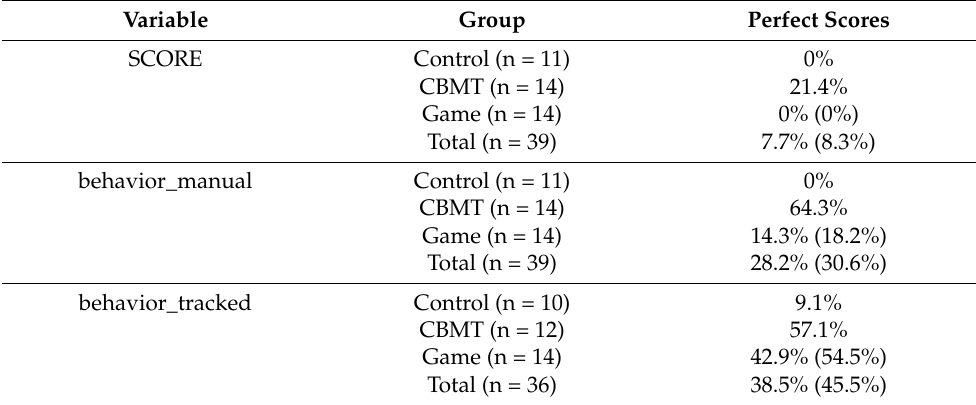
Table 3. Proportions of perfect scores.